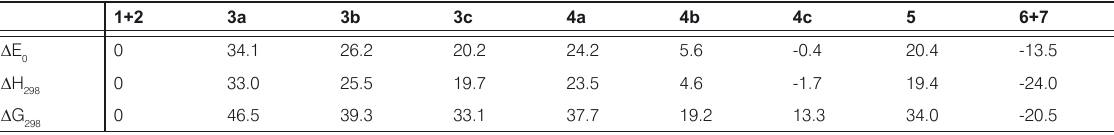
= Me, R = OH, R = Me. 1 2 3